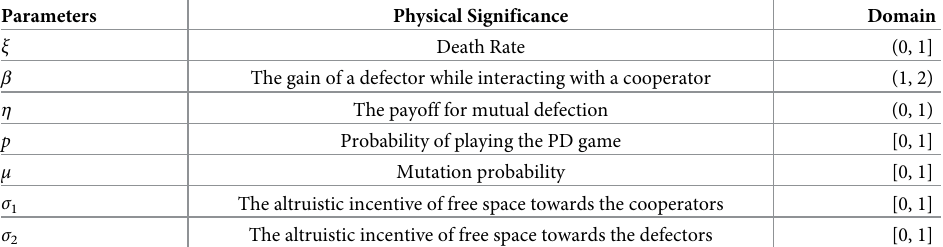
Table 1. Parameters with their physical significance and domains: The first column represents the symbols used in the present manuscript to describe several parameters. At the same time, the second column depicts what these parameters exactly mean. The set of possible input values from which the parameters can assume their values is given in the third column of the table. For further details, please see the main